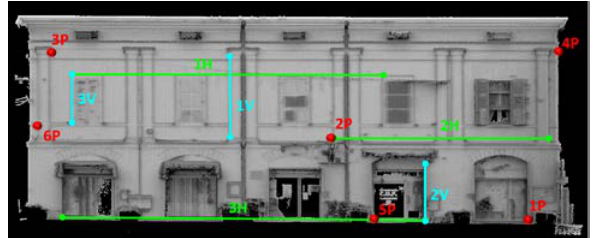
Figure 9. Elements chosen on the Guerrini-Forti palace façade, used for the comparison between the photogrammetric and the TLS